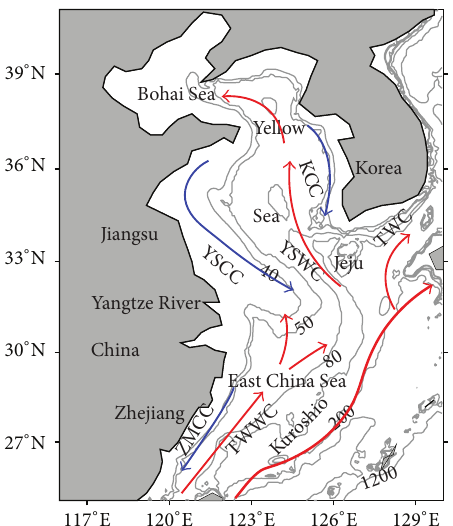
Figure 1: Schematic map of winter circulation in the Yellow Sea and East China Sea. The red arrows denote the warm currents and the blue arrows denote the cold currents. Gray lines are the bathymetry with 50, 80, 200, and 1200 m labeled. The warm currents include the Yellow Sea Warm Current (YSWC), the Taiwan Warm Current (TWWC), the Tsushima Warm Current (TWC), and Kuroshio. The cold currents include the Zheming Coastal Current (ZMCC), the Yellow Sea Coastal Current (YSCC), and Korea Coastal Current (KCC). This figure is based on [26, Figure 1